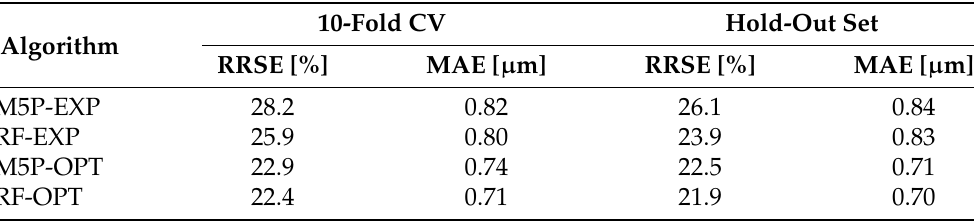
Table 1. Prediction error